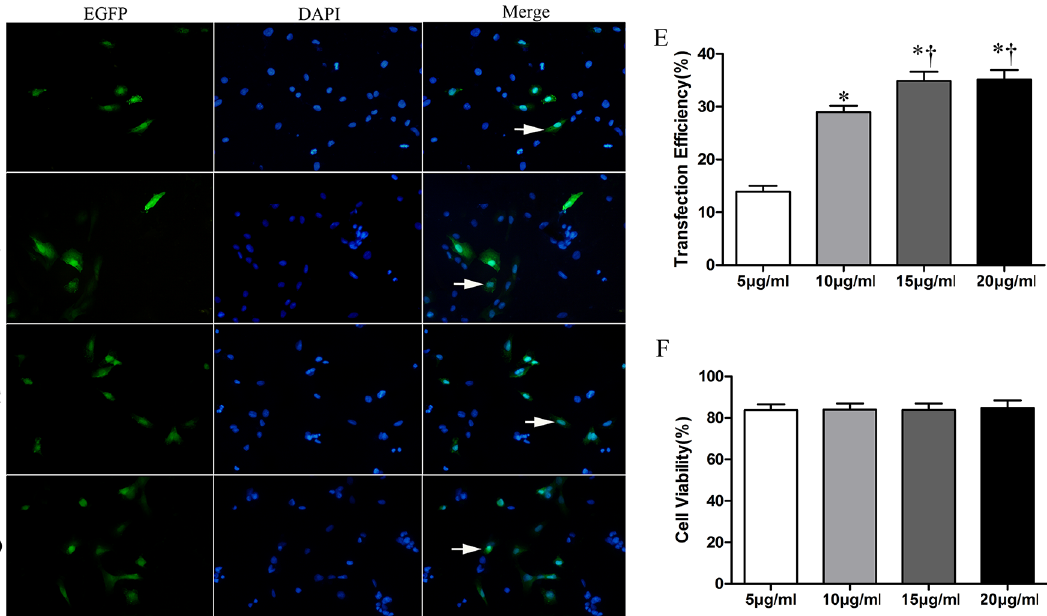
Fig 4. The effect of PC on transfection efficiency and cell viability. A-D showing EGFP expression at PC 5 μ g/ml,10 μ g/ml,15 μ g/ml, 20 μ g/ml in sequence. E showing transfection efficiency at different PC with when MC (30%), AI (1.5 W/cm 2 ), and ET(30 s) were fixed. F cell viability at different PC with when MC (30%), AI (1.5 W/cm 2 ), and ET (30 s) were fixed. Indication: Symbols indicate significant differences ( P < 0.05) from ET of 5 μ g/ml( * ) or 10 μ g/ml ( † ).